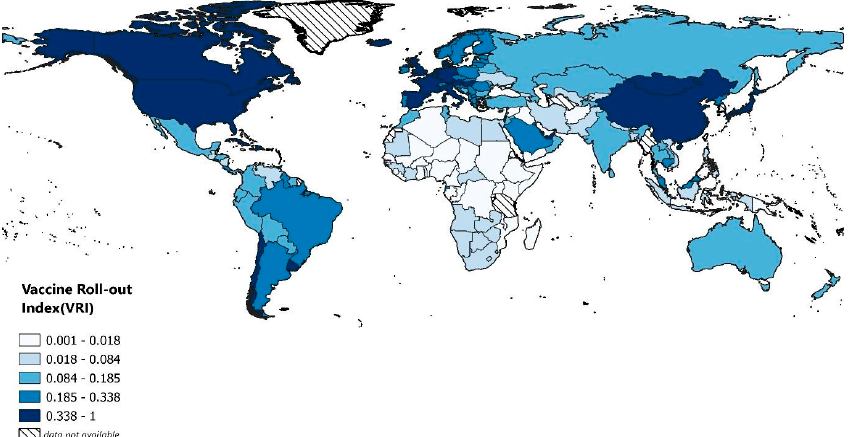
Figure 3. Heatmap of studied countries. They are colored based on their Vaccine Roll-out Index ( VRI ) value. All VRI values were multiplied by a constant to be in the range of 0 to 1. Five intervals were selected such that the number of countries in each one was the same.